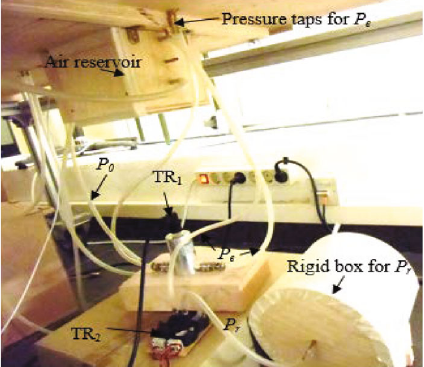
Figure 2: Experimental setup (same as Figure